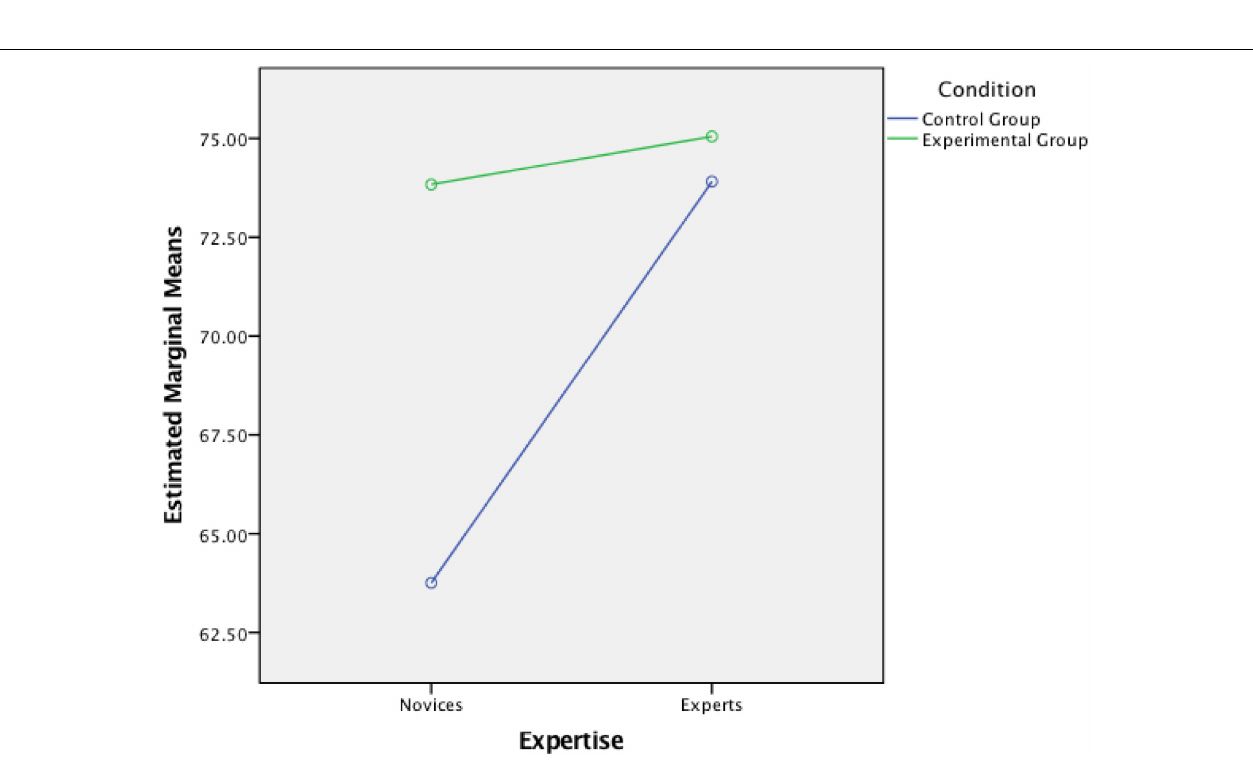
FIGURE 6 | The interaction effect between expertise and condition on the first design artifact.